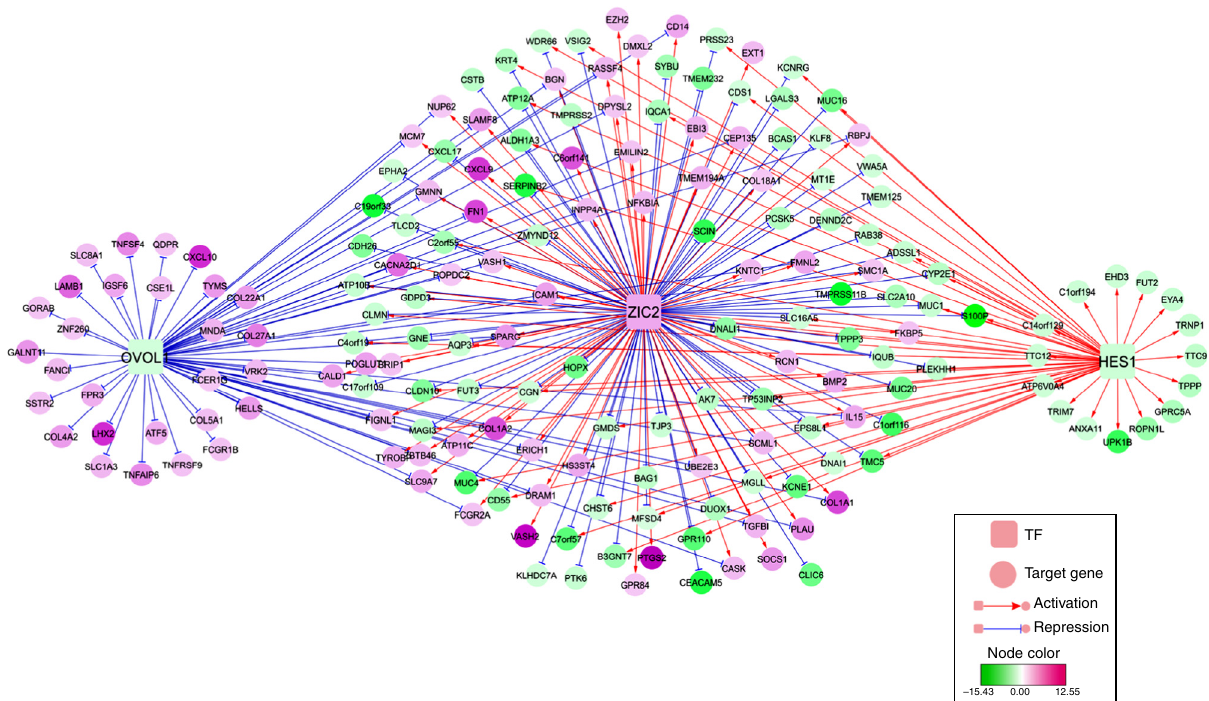
The regulatory network of Transcription Factors (TFs, such as ZIC2, OVOL and HES1) and their targeted differentially expressed genes